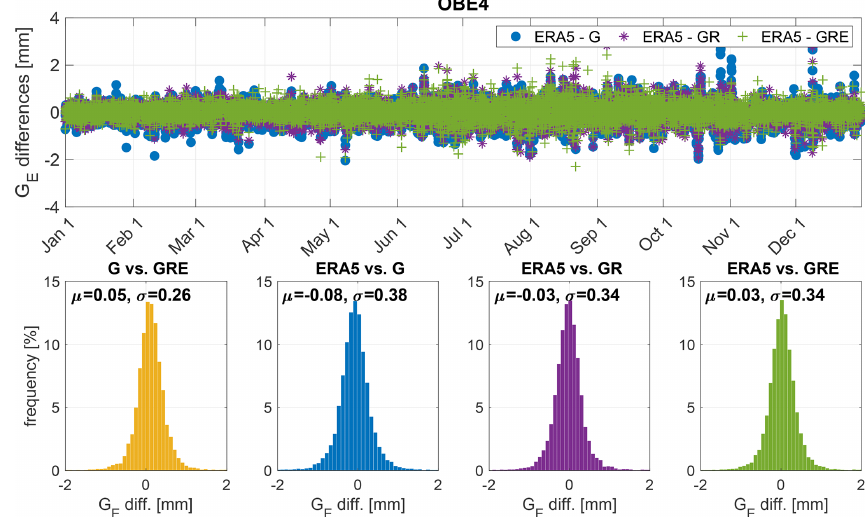
Figure 12. The G E differences between the three GNSS solutions: GPS-only, GR and GRE and ERA5 for station OBE4 (Oberpfaffenhofen, Germany) (top) and the histograms of the differences (bottom). The statistics were calculated from the year